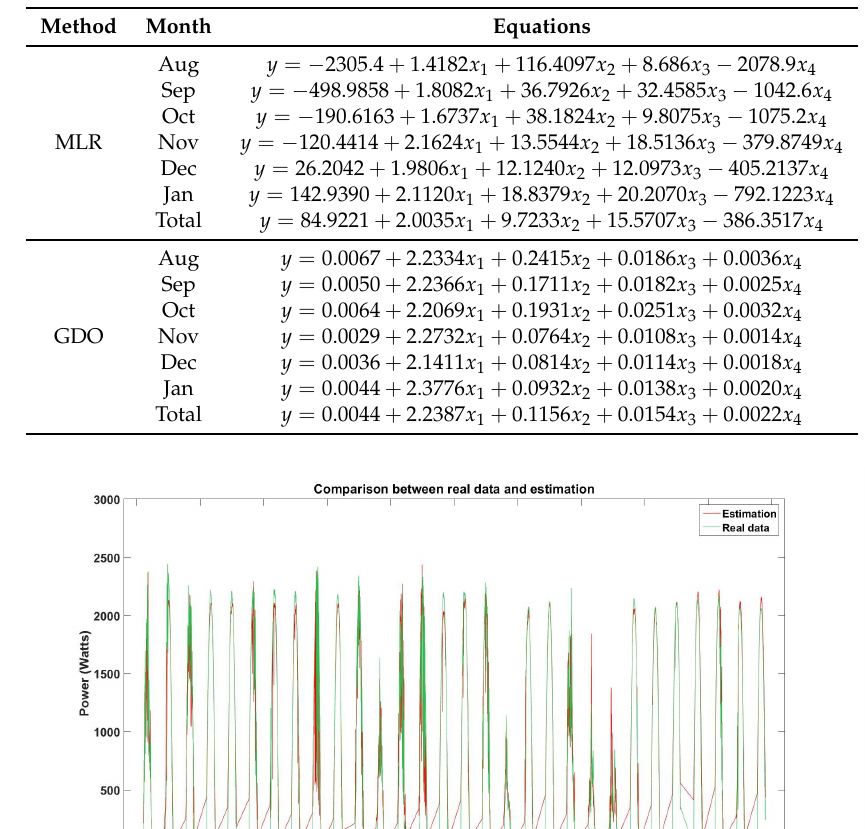
Table 1. Monthly and overall Multiple Linear Regression (MLR) and Gradient Descent Optimization (GDO) equations for HS.